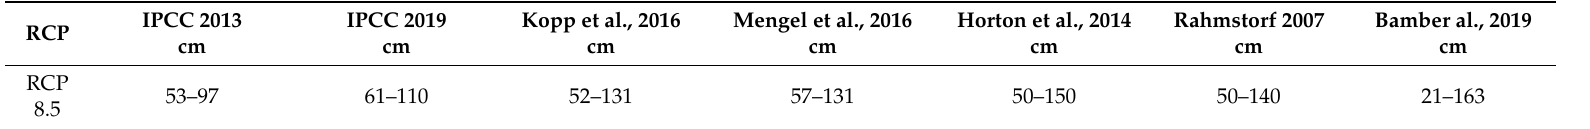
Table 1. Global projections (cm) of sea-level rise at 2100 for di ff erent authors.